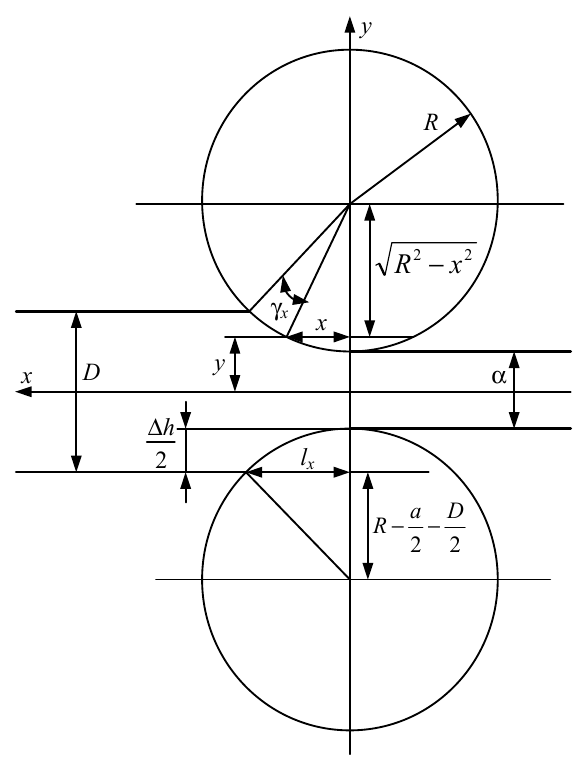
α l and tg α . Figure 4. Explanations for the derivation of equations for l x and tg x x x